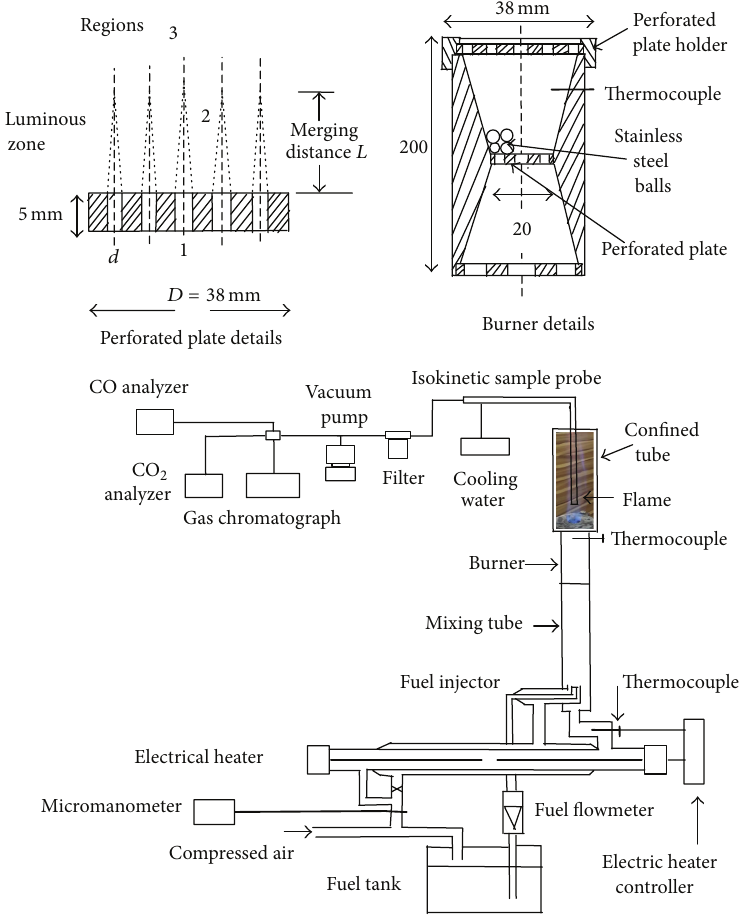
Figure 1: Experimental